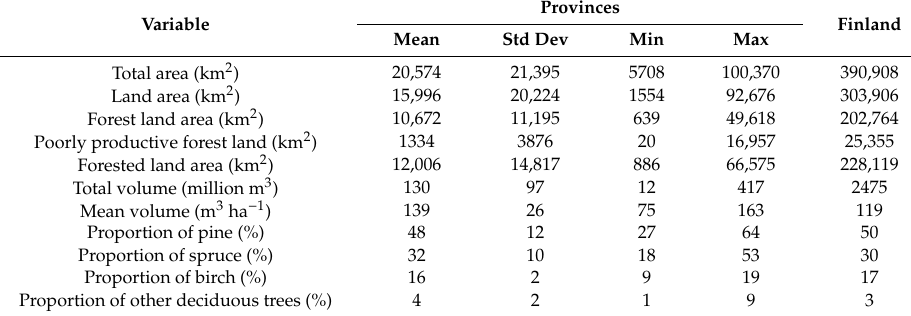
Table 1. Forest estimates based on the NFI12 field plots and total and land areas based on the statistics of the National Land Survey of Finland (in 2018) for the provinces ( N = 19) and the whole of